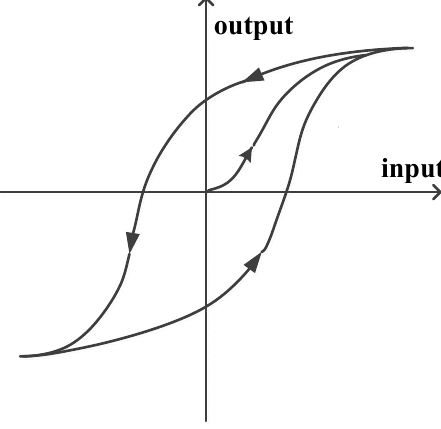
Figure 1. Hysteresis loop of piezoelectric materials which is a memory-like effect, and the output is independent of the input.